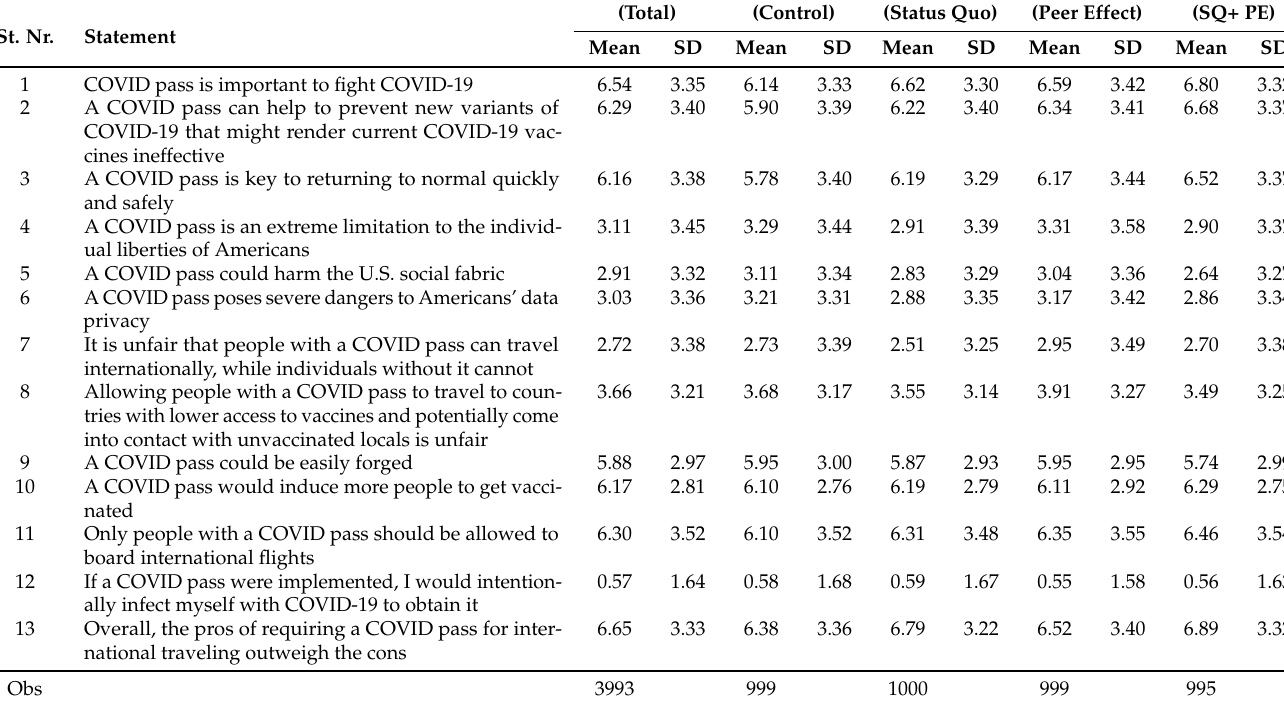
Table 1. List of statements with their respective number and summary statistics (mean and standard deviation). Participants were asked to state their agreement with the following sentences on a scale from 0 to